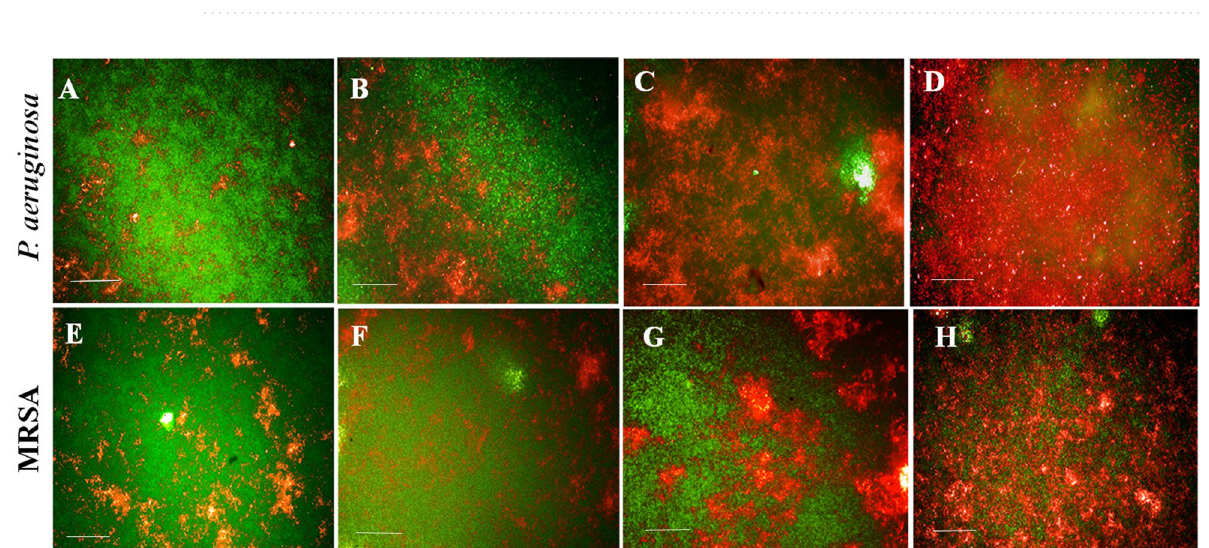
Figure 12. Membrane integrity assessment of preformed biofilms—Live and dead cells differentiated syto 9 & PI stained P.aeruginosa and MRSA biofilms with treatment combinations. ( A , E ) Control biofilms without treatment, ( B , F ) Biofilms treated with LP alone, ( C , G ) Biofilms treated with Cu-NPs alone, ( D , H ) Biofilms treated with LP + Cu-NPs (50